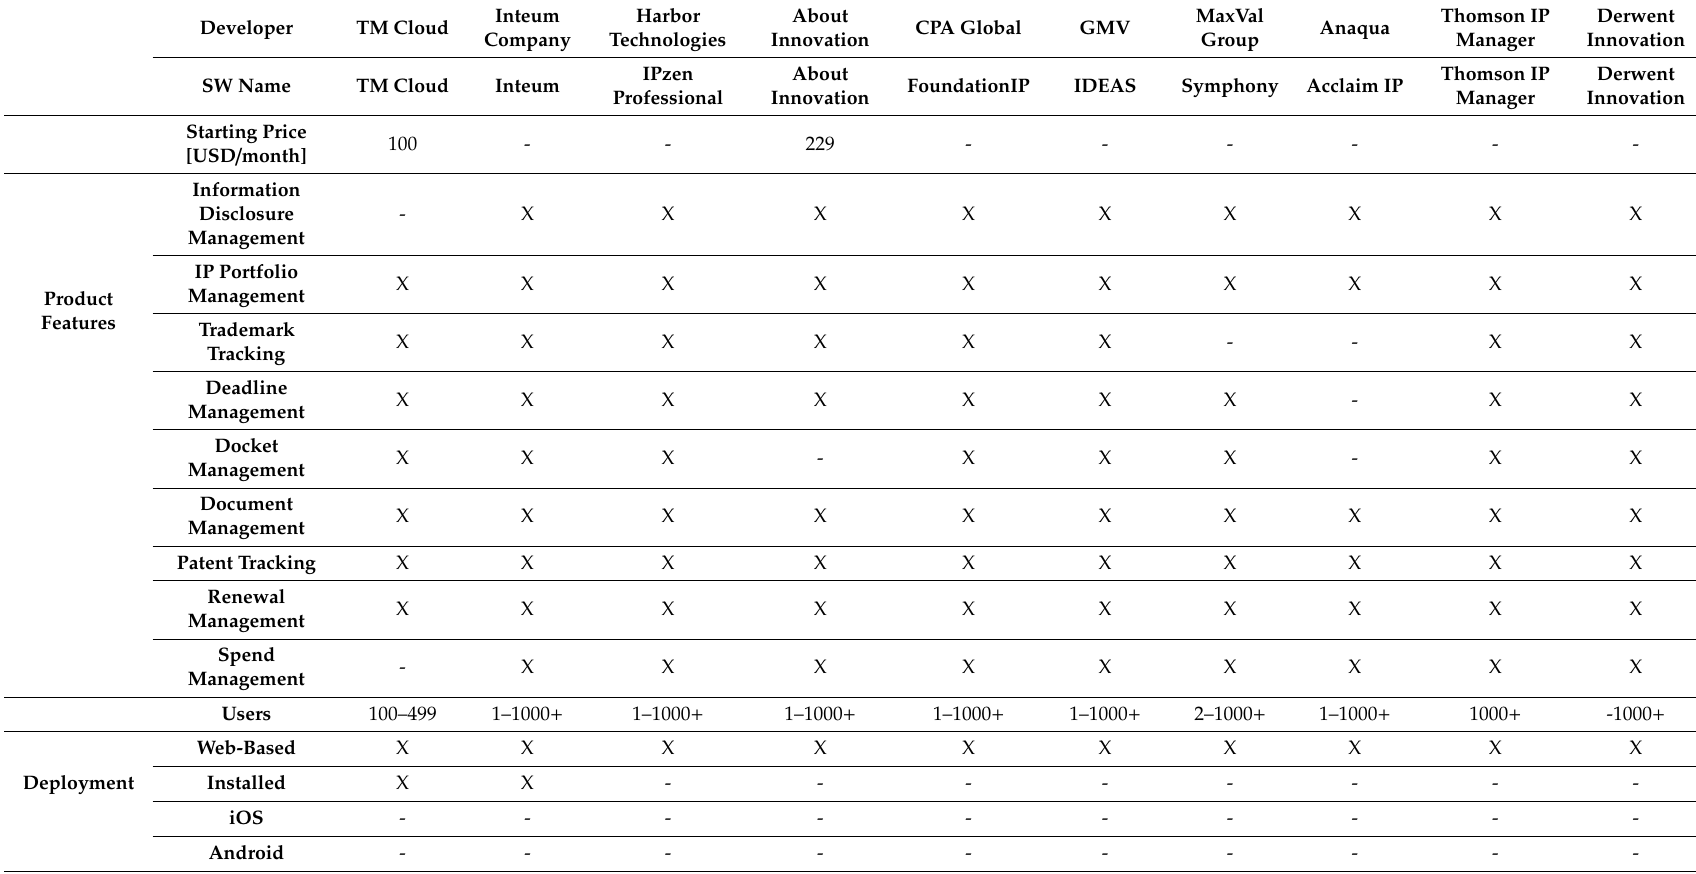
Table 1. Selected SW solutions for managing intellectual properties with main